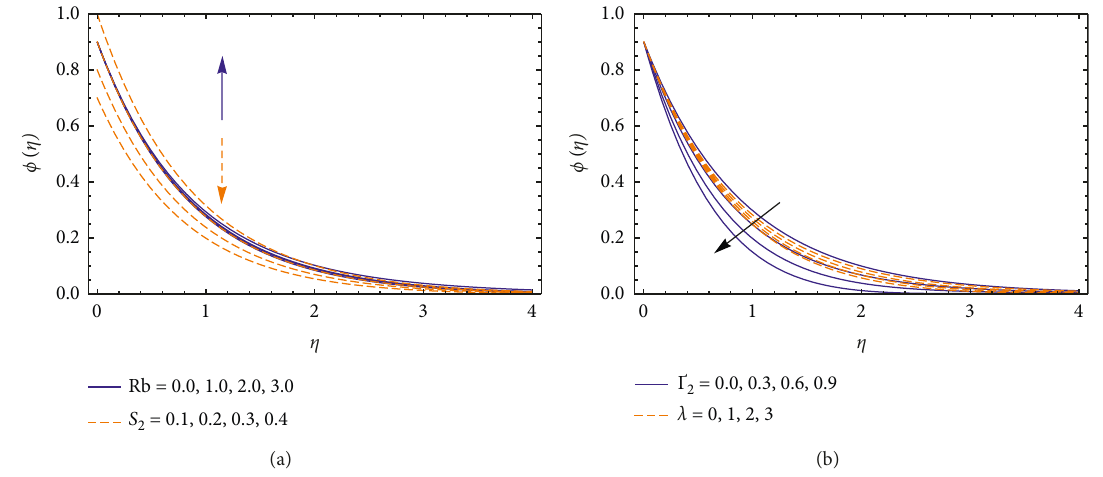
Figure 4: Nanoparticle concentration profile for different values of Ha, Rb,S